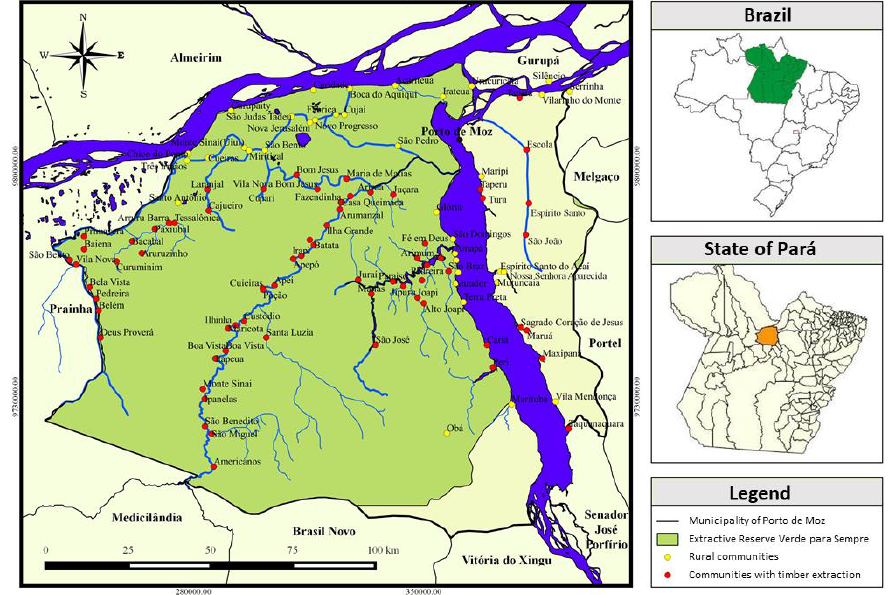
Figure 3. Communities where families log their forests in the municipality of Porto de Moz. Source: Fieldwork.